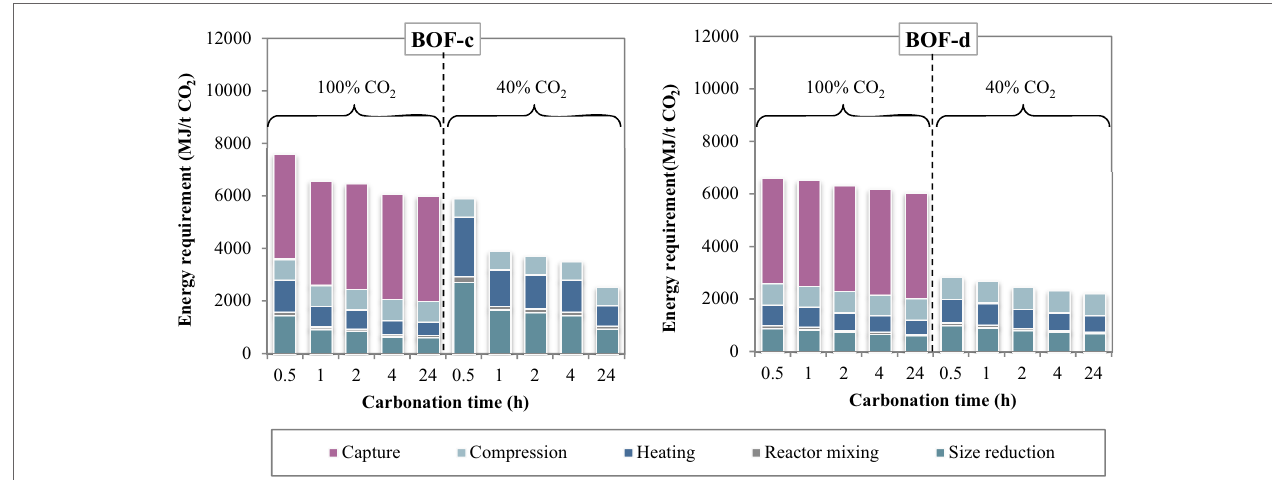
FigUre 5 | energy requirement of each unit operation as a function of the carbonation conditions (thin-film route)